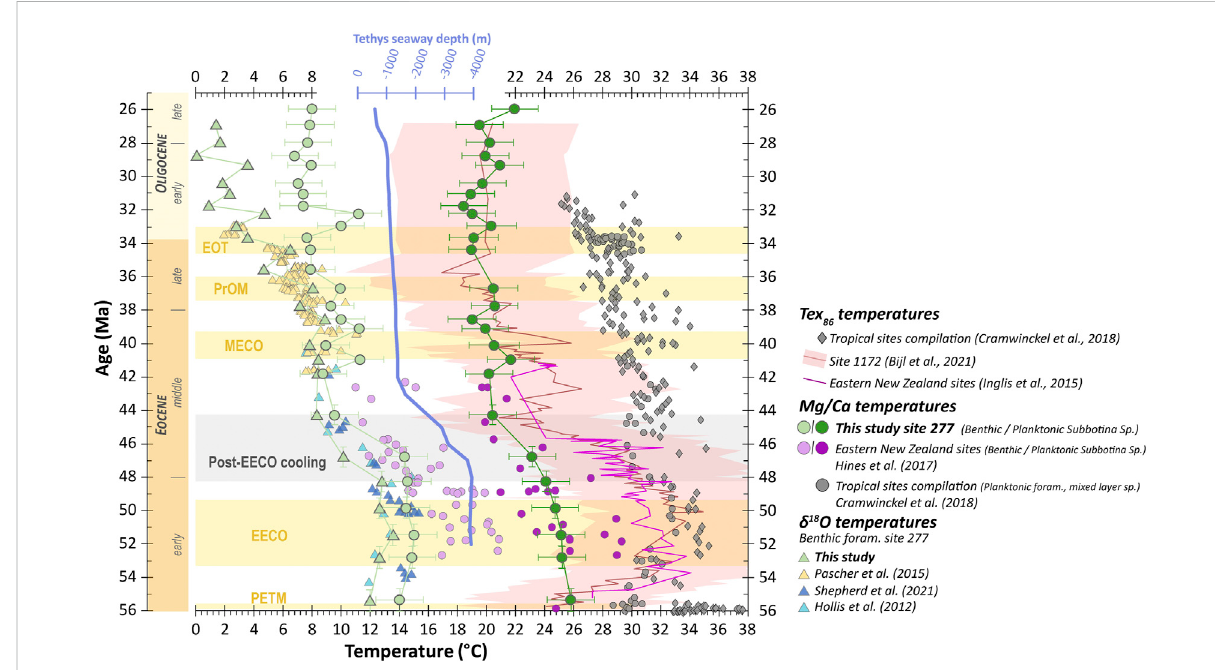
FIGURE 8 Temporal evolution of foraminiferal Mg/Ca- and δ 18 O-derived SSTs (here thermocline temperatures obtained on Subbotina sp. foraminifera) and SFTs (sea fl oor temperatures obtained on Cibicidoides sp. and Gyroidinoides sp. ) compared to available data from Hollis et al. (2012), Pascher et al. (2015), Hines et al. (2017), and Shepherd et al. (2021). TEX 86 -derived SSTs (mixed-layer temperatures) for Site 1172 (Bijl et al., 2021) and Eastern New Zealand sites (Mid-Waipara and Hampden, Inglis et al., 2015) are also represented for comparison. Compilation of Mg/Ca- and TEX 86 - derived SSTs (mixed-layer temperatures) from tropical sites worldwide by Cramwinckel et al. (2018) is also shown for comparison. It is worth noting thatthepost-EECO cooling thatwe andotherauthorsnoticedinthesouthwestPaci fi cOcean isnot visibleinthatcompilation.Tethysseawaydepth evolution is from Straume et al.